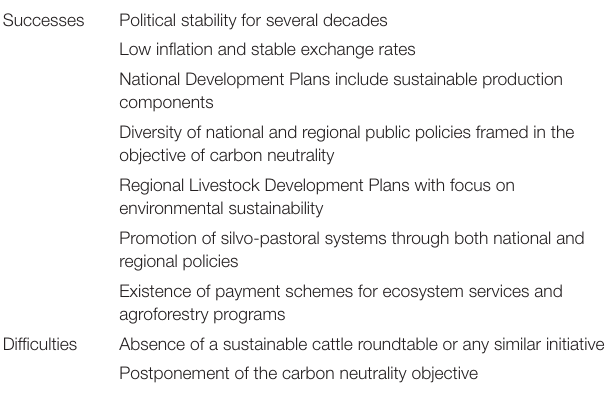
TABLE 6 | Successes and difficulties in the implementation of public policies in Costa